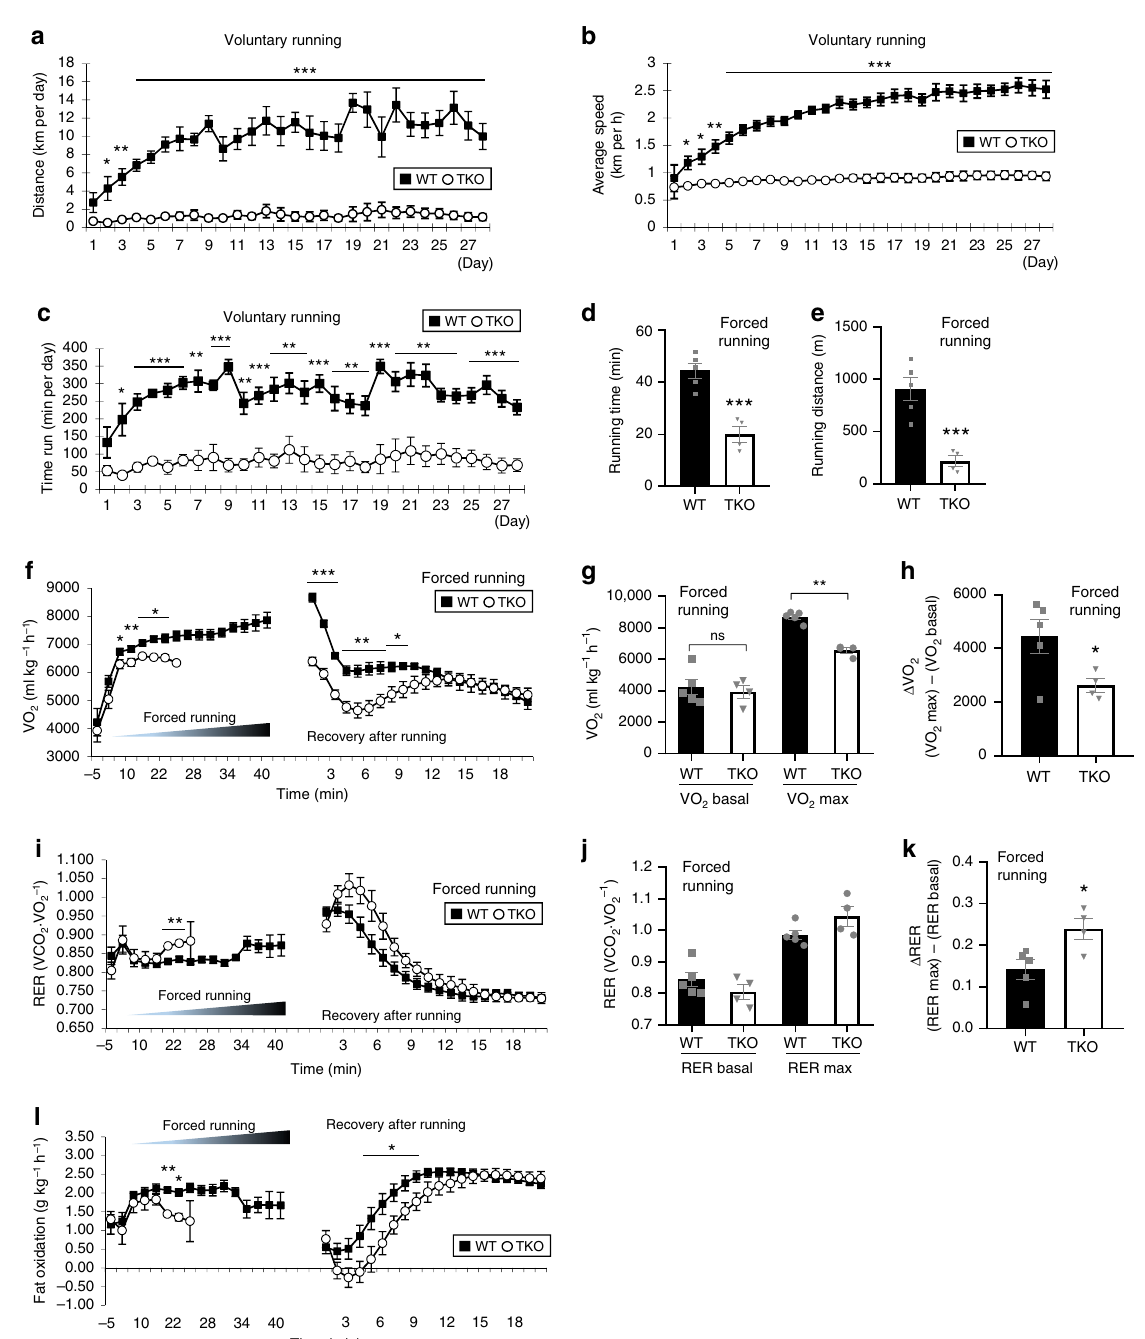
Fig. 4 Sesn1-3 triple knockout mice display drastic impairment in exercise response. 5-month-old WT and Sesn1 − / − / Sesn2 − / − / Sesn3 − / − (TKO) mice (C57BL/6 background) were subjected to voluntary wheel running for 1 month. Running distance ( a ), speed ( b ) and time ( c ) were recorded. Mice were then subjected to incremental exercise (forced running of increasing intensity until exhaustion) with indirect calorimetry ( d – l ). VO 2 , oxygen consumption rate. VO 2 basal, baseline VO 2 . VO 2 max, maximum VO 2 . Δ VO 2 , VO 2 max − VO 2 basal. VCO 2 , CO 2 production rate. RER, respiratory exchange ratio. RER basal, baseline RER. RER max, maximum RER. Δ RER, RER max – RER basal. Biologically independent animals: n = 5, 4 ( a – l ; WT and TKO mice, respectively). Error bars, s.e.m. * P < 0.05, ** P < 0.01, *** P < 0.001 or ns, non-signi fi cant from a two-tailed student ’ s t